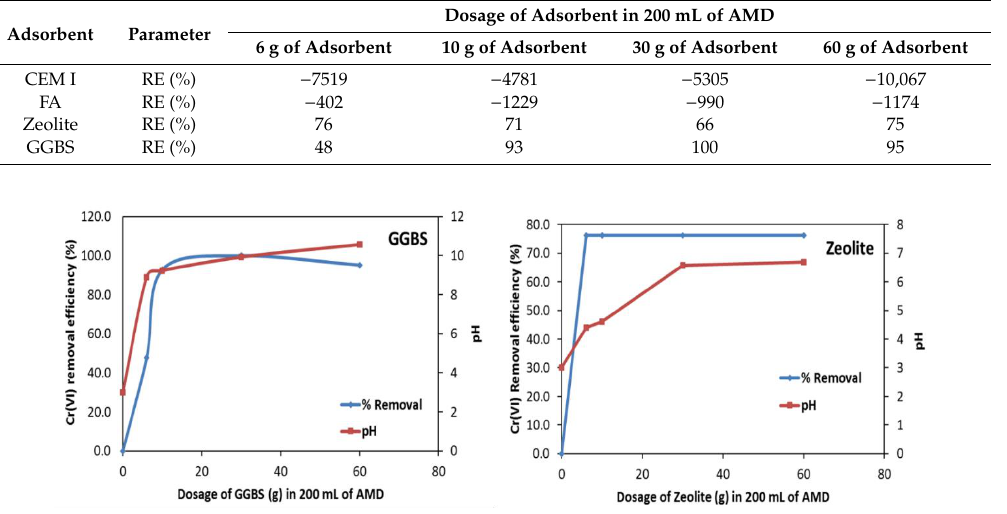
Figure 3. Influence of adsorbent dosage on pH and removal efficiency .